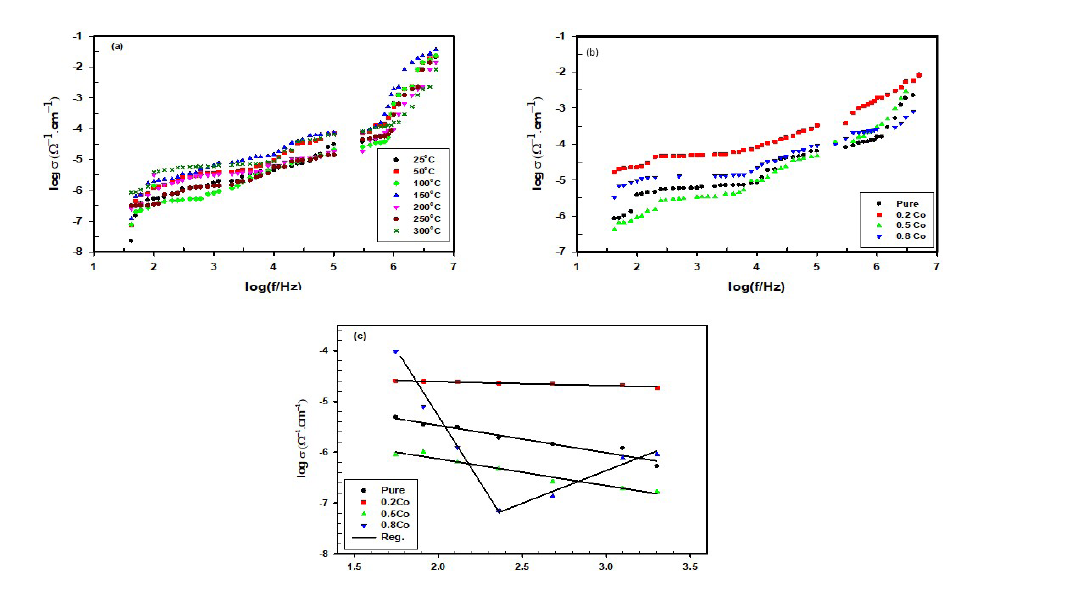
Figure 8. Variation of conductivity with frequency for (a) Zn-ferrite prepared by microwave method at 1000 o C (b) for pure Zn-ferrite and Co-Zn-ferrite at at 300 o C (c) The relation between the variations of conductivity as a function of the reciprocal of temperature at 100